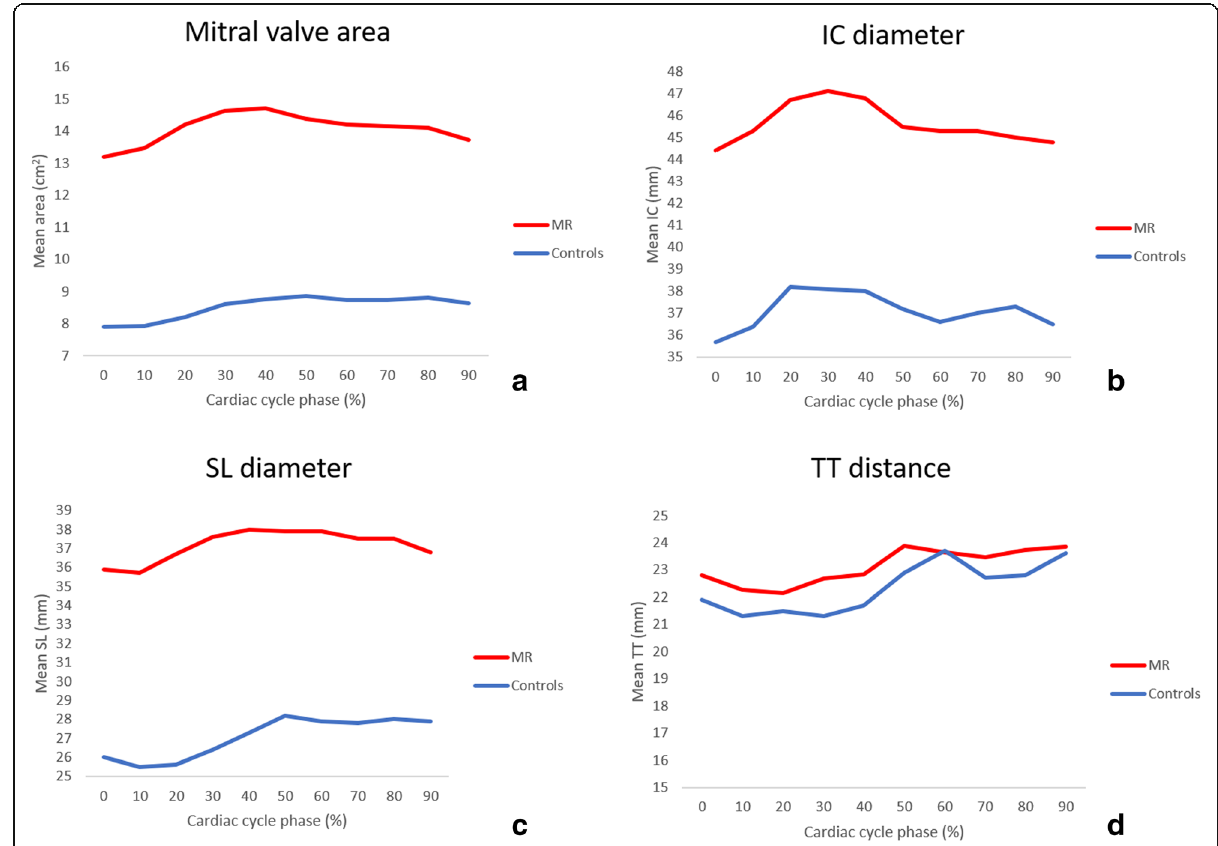
Fig. 4 Mitral valve dimension modification during the cardiac cycle in mitral regurgitation and control patients